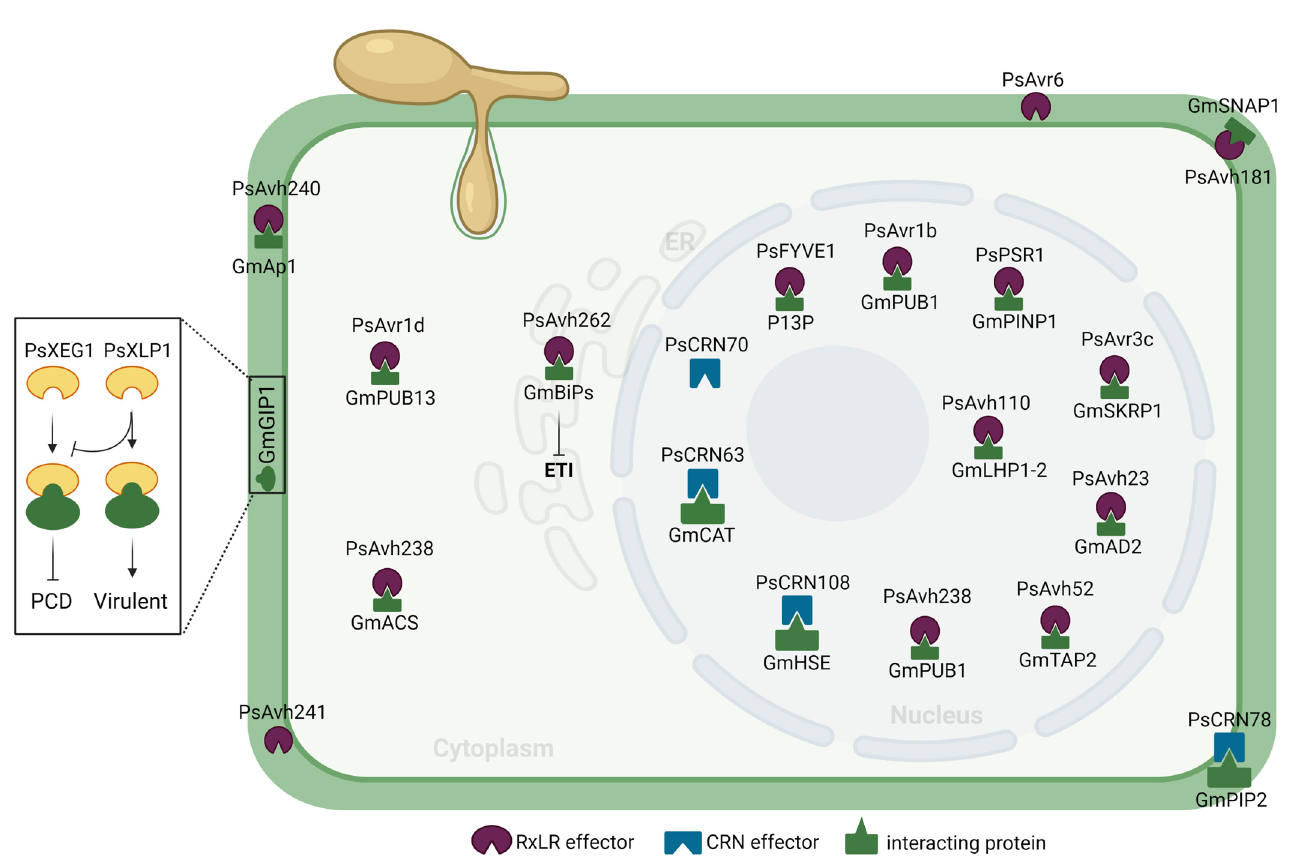
Figure 2. Subcellular localization and corresponding host targets of Phytophthora sojae candidate secreted effector proteins (CSEPs) based on current literature. The insert to the left depicts the effector PsXEG1 and its decoy PsXLP1 binding to GmGIP1 in the apoplast to create an incompatible (programmed cell death (PCD) or a compatible (Virulent) interaction, respectively.